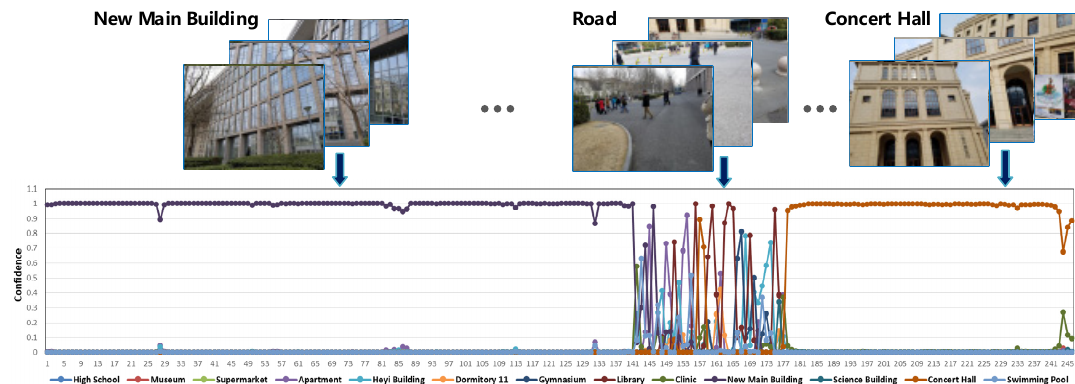
Figure 13. AlphaMEX CNN ‐ based location estimation result from Apartment to High School. Each dot in the chart represents the confidence of each frame, with different colors representing scene classes (shown in the legend). When the wearer walked in a typical scene area, the algorithm demonstrated the absolute confidence of its estimation (from first frame to 61, 116 to the end), but demonstrated random noise when the wearer walked by the road (62 to 115).